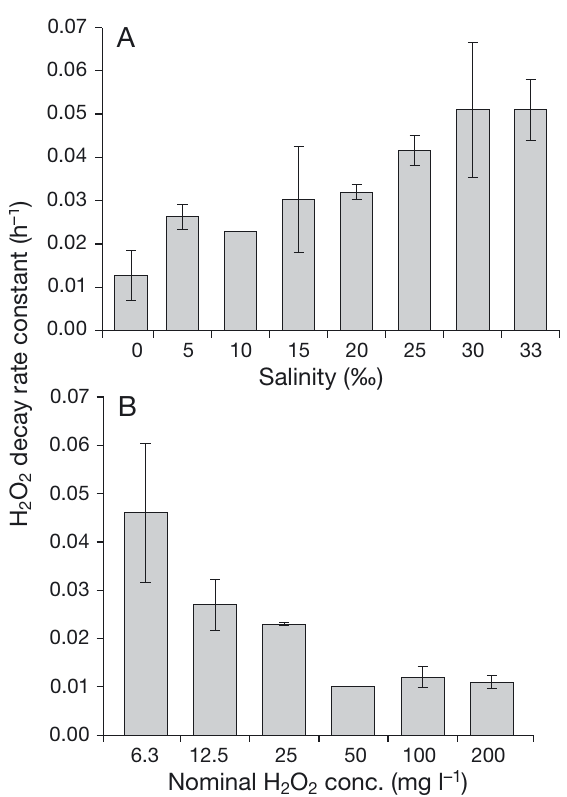
Fig. 6. (A) Calculated decay rate constants of H 2 O 2 (mean ± SD) derived from beaker experiments at 20°C. Divosan Forte was added to water samples with different salinities at an ini- tial concentration ( C 0 ) of 1 mg l −1 PAA which corresponded to a C 0 of 1.6 mg H 2 O 2 l −1 . (B) Decay rate constants of H 2 O 2 5. Calculated decay rate constants PAA derived from tri- (mean ± SD) derived from beaker experiments at 22°C with als with addition of PAA to tanks with 300 l seawater at 15°C different initial H 2 O 2 concentration added to full-strength in initial concentrations of 0.15, 0.30, 0.60, 1.20 and 2.4 mg l −1 seawater. Values are based on duplicate experiments, except PAA (n = 20). Each symbol represents a calculated PAA decay C 0 = 50 mg H 2 O 2 l −1 where an outlier is rate constant from an individual tank trial. Trial 1 included 25 kg m −3 salmon post-smolts exposed for 5 min, and trial 2 in- cluded 10 kg post-smolts exposed to PAA for 30 min before transfer. The grey squares represent a subsequent trial where 4.8 mg l −1 PAA was added to 2 tanks with 500 l seawater (15°C) in which 15 kg m −3 post-smolts were exposed to PAA for 30 min (n = 2)